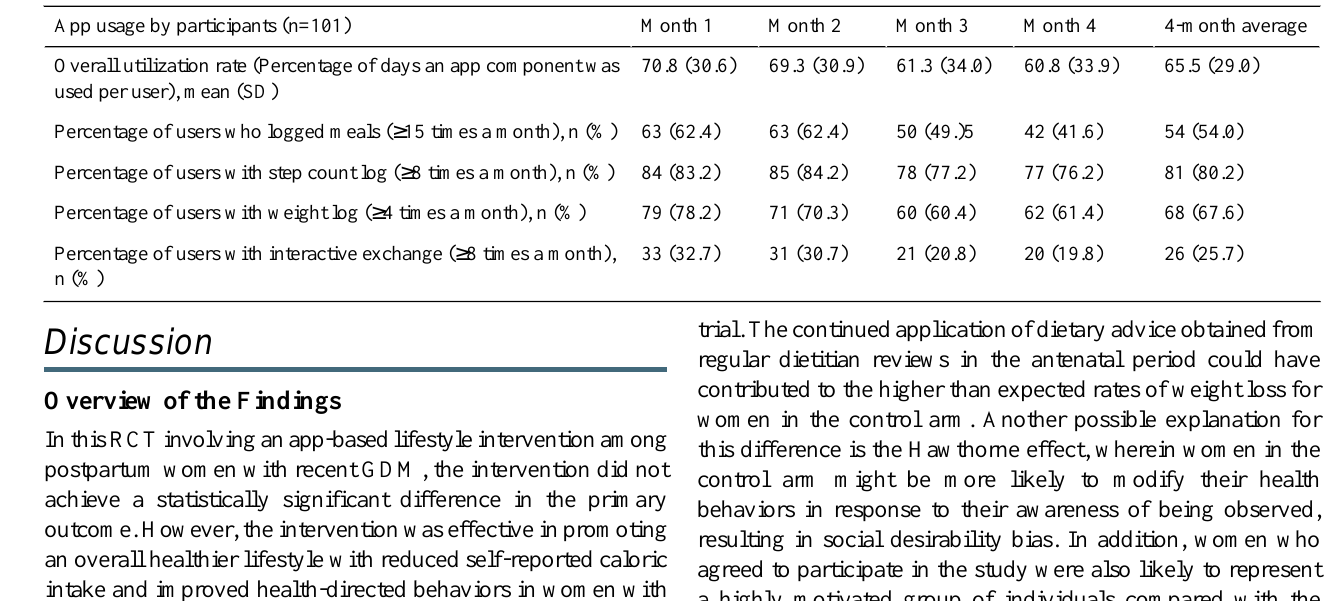
Table 5. Participant engagement with the app in the intervention